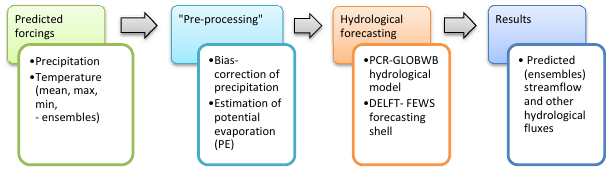
Figure 1. Approach followed in the forecasting system for the Limpopo River